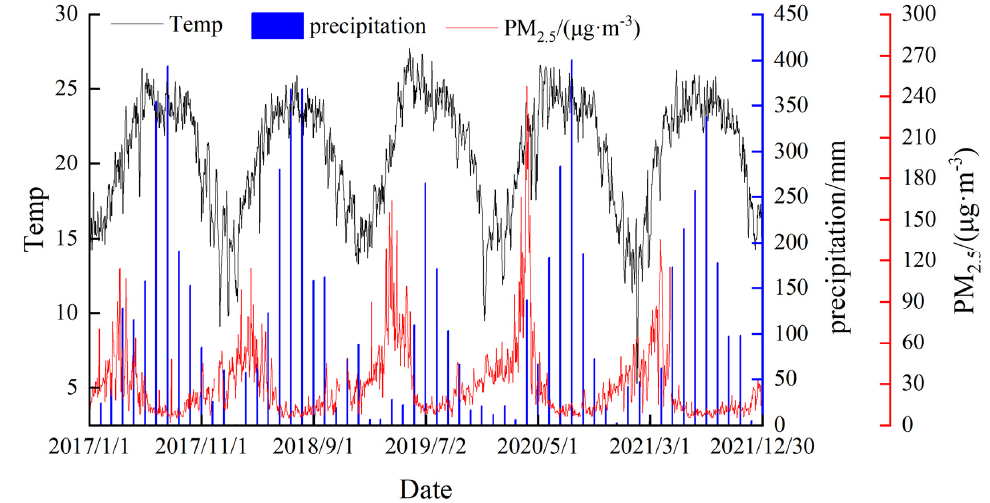
Figure 3. Relationship between temperature, precipitation, and PM 2.5 .